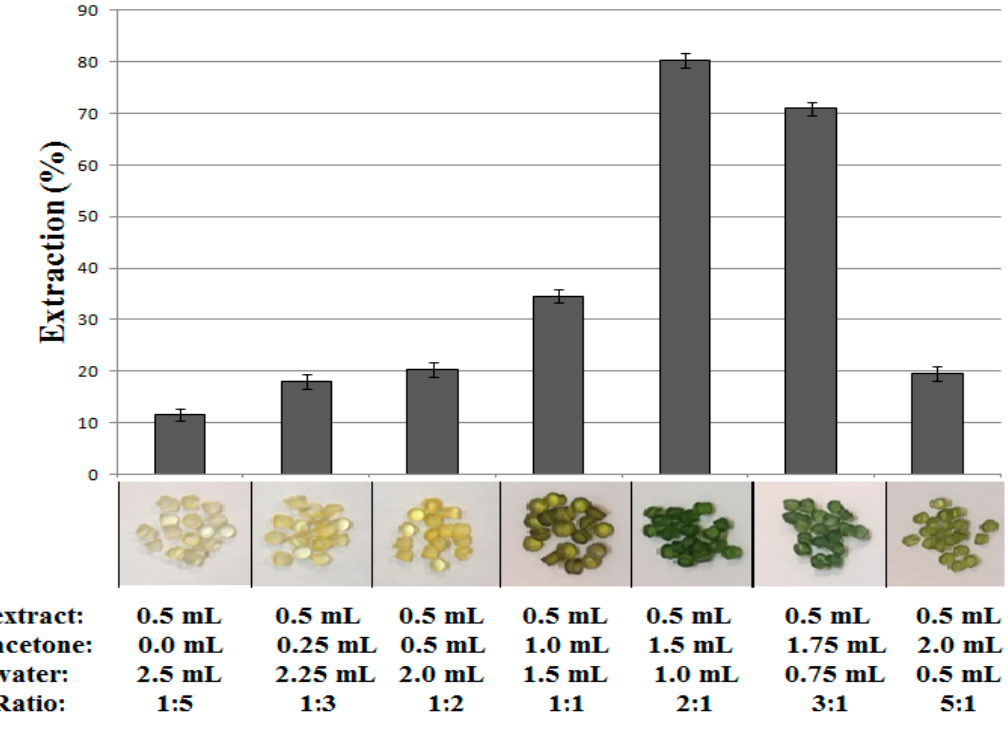
Figure 2. The influence of the volume ratio of acetone/water (ratio v / v ) on chlorophyll a extraction efficiency (%) on 300 mg of PVC. The HPLC quantification was performed after 10 min at room temperature in batch experiments.